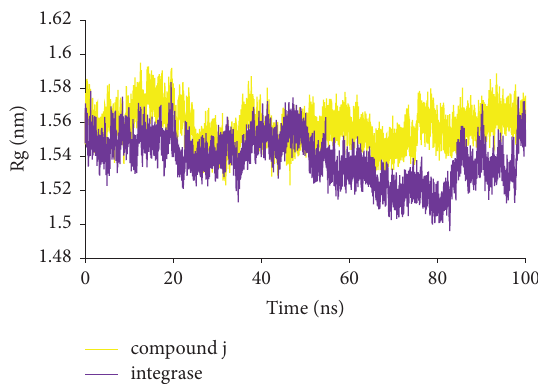
Figure 12: Plot of Rg changes of alpha carbon integrase during 100ns of simulation in connection with compound (j) for integrase in purple and for integrase in the presence of compound (j) in